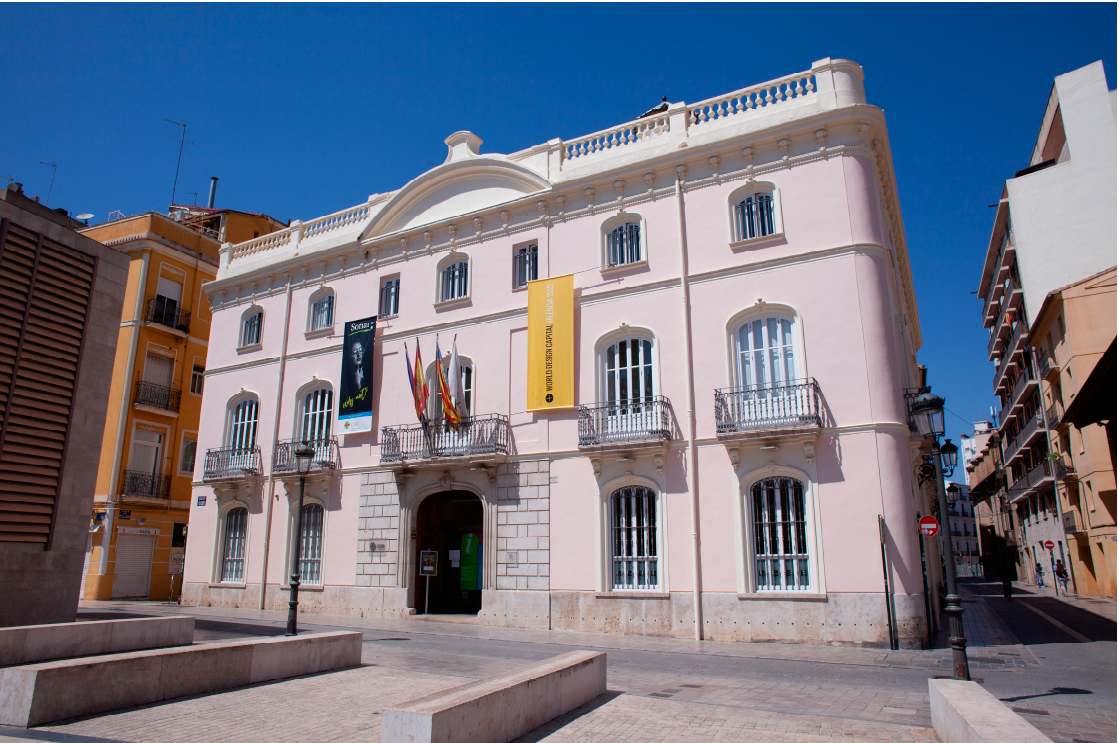
Figure 1. Colomina Palace (southern façade).